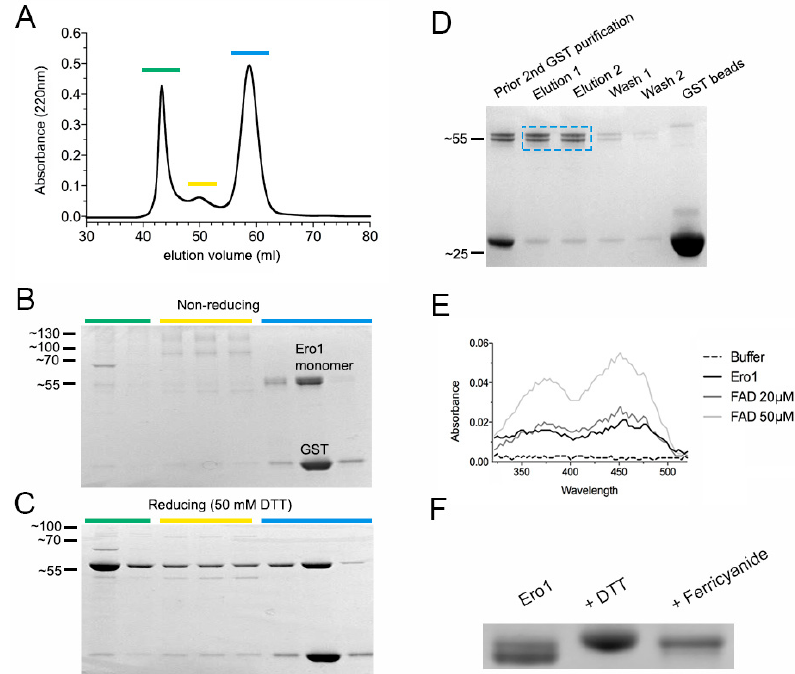
Figure 2. Expression and purification of recombinant Conus geographus Ero1 (isoform X1). ( A ) Size exclusion chromatography (SEC) chromatogram of reduced glutathione (GSH)-agarose purified Ero1 after proteolytic cleavage from the glutathione S-transferase (GST)-fusion partner. SEC fractions (colored in green, yellow and blue) were analyzed by ( B ) non-reducing and ( C ) reducing SDS-PAGE. Fractions containing the Ero1 monomer co-eluted with GST and required additional